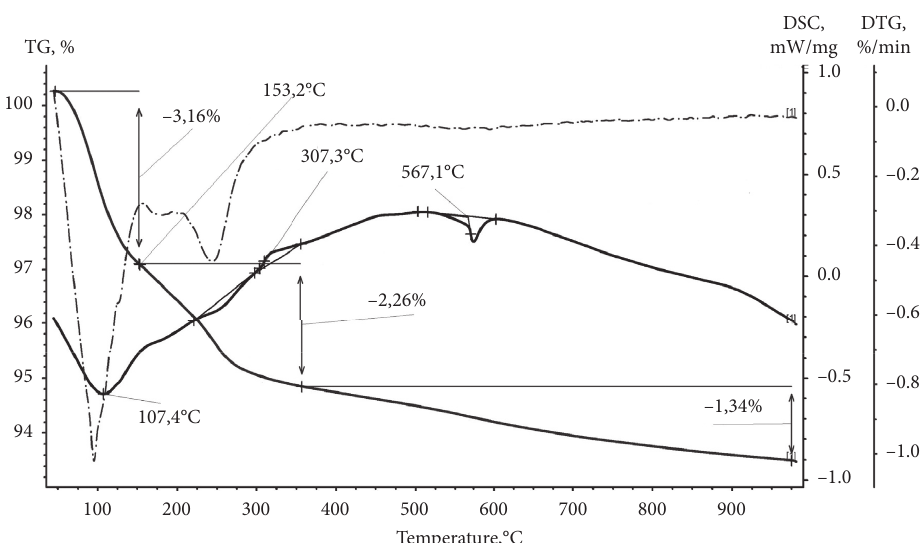
Figure 2: Differential thermoanalyses of the composition of dust silicon (5 mass units) and orthophosphoric acid (3 mass units).